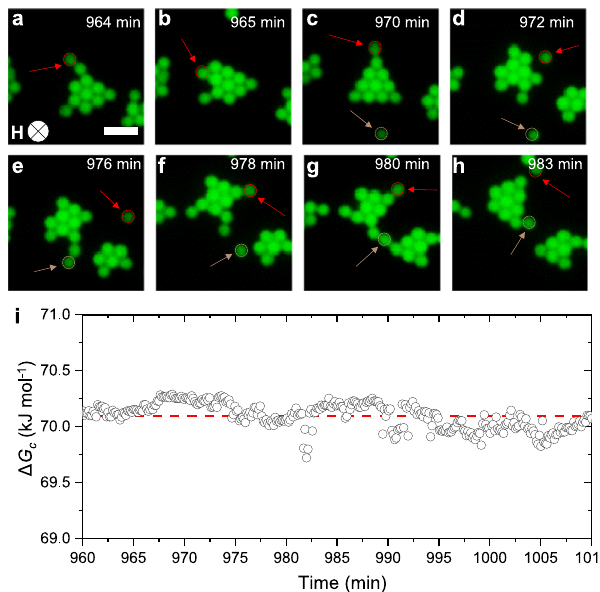
Fig. 5 Dynamic cluster formation. a – h Time-sequence showcasing typical rearrangement of individual microparticles in dynamic clusters over 20 min, with H = 290 A m − 1 . Scale bar: 3 μ m. i Change in Gibbs free energy of clusters over 50 minutes, calculated from image analysis obtained after 12 h of equilibration at H = 290 A m − 1 . The dashed line is a linear fi t showing a mean value of 70.1 kJ mol − 1